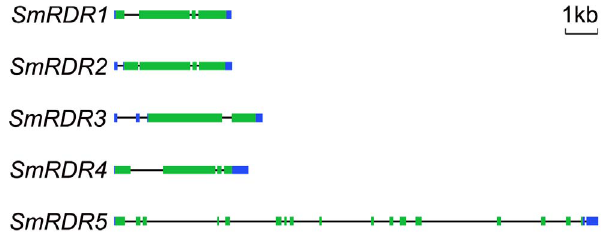
Figure 1. Gene structures of S.miltiorrhizaSmRDRs . Filled boxes represent exons with coding regions in green and 5 9 - and 3 9 -UTRs in blue. The connecting lines represent introns.